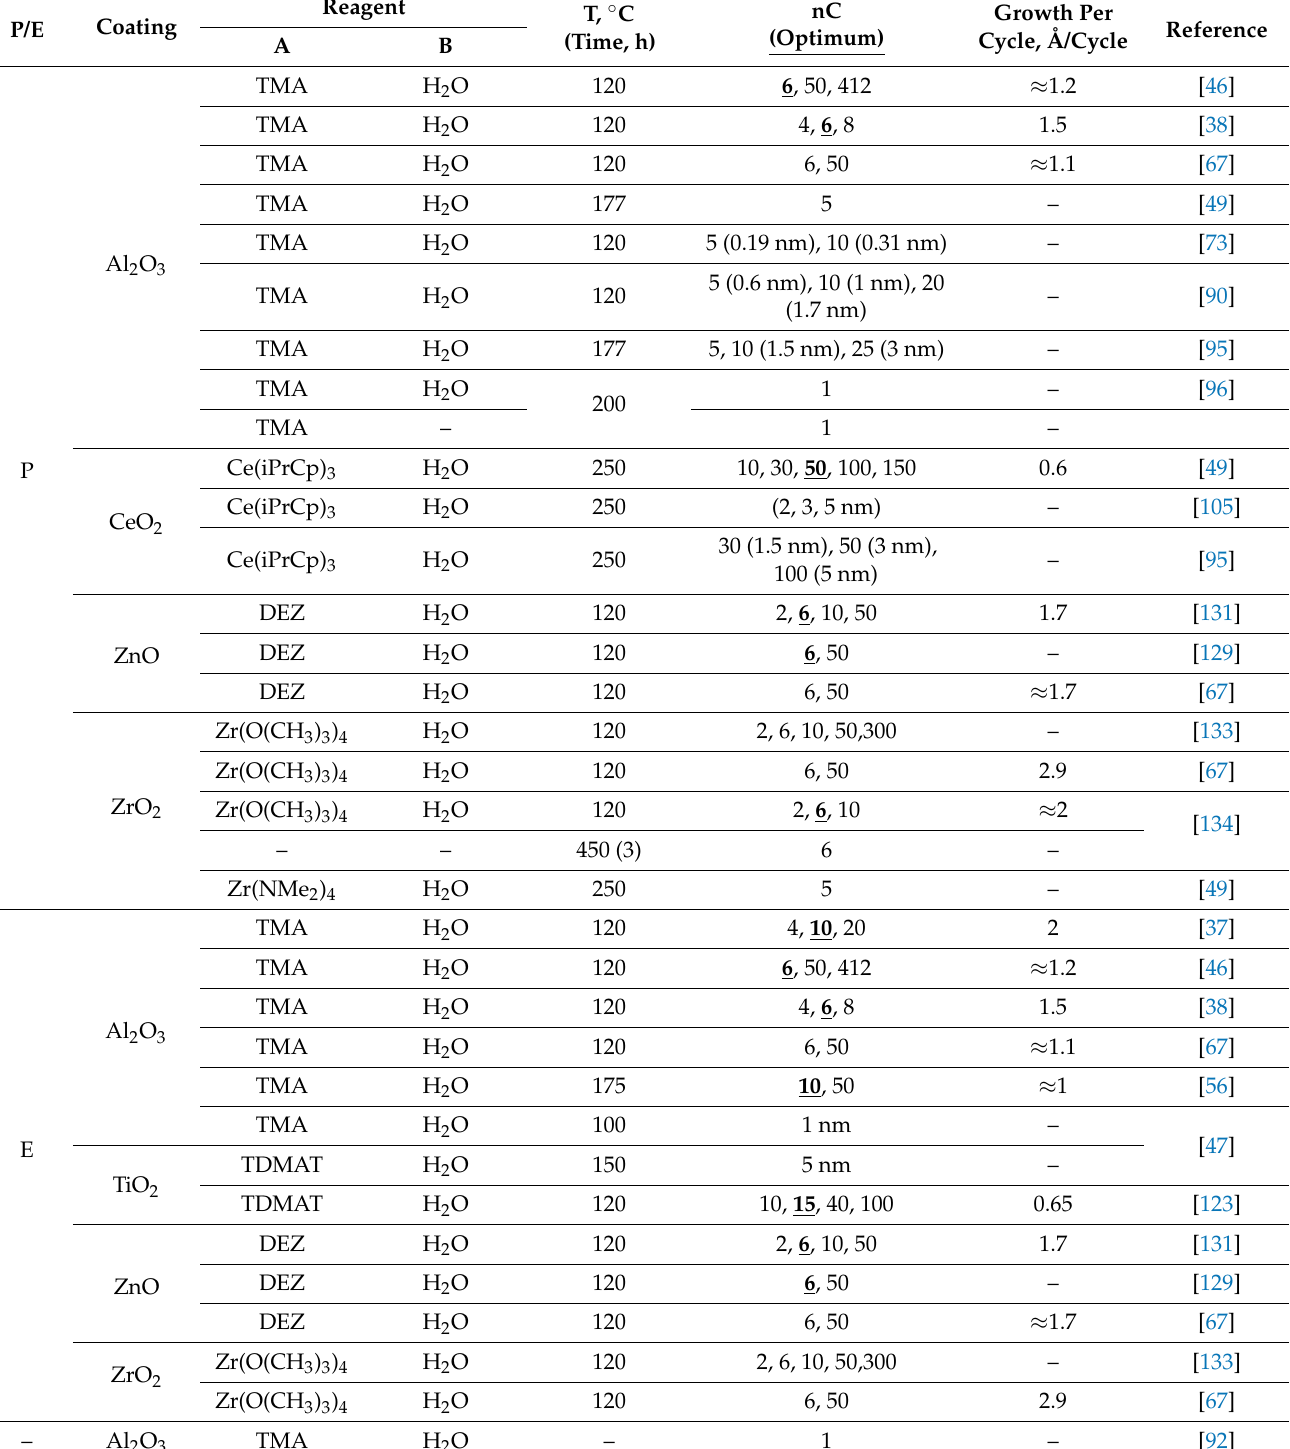
Table 2. Main parameters of LMO (LiMn 2 O 4 )